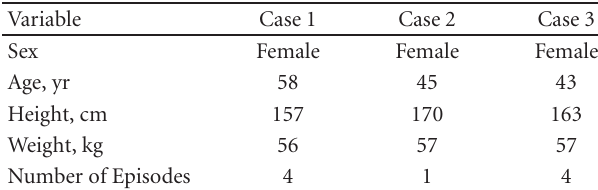
Table 2: Characteristics of the case